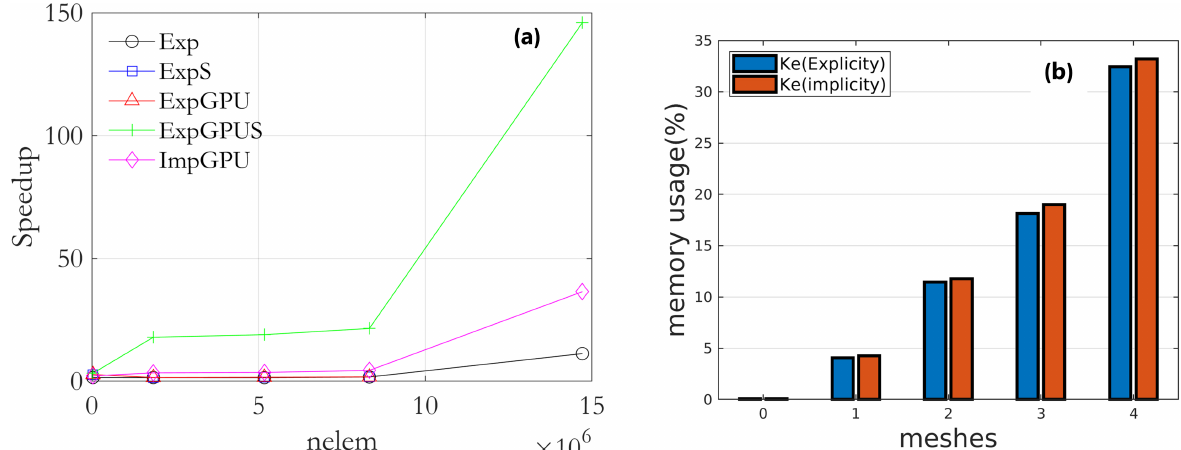
Figure 10. (a) Speedup of the construction of arrays of elements in relation to the Imp technique (b) Comparison of percentage of memory used by Ke assembled explicitly and implicitly.